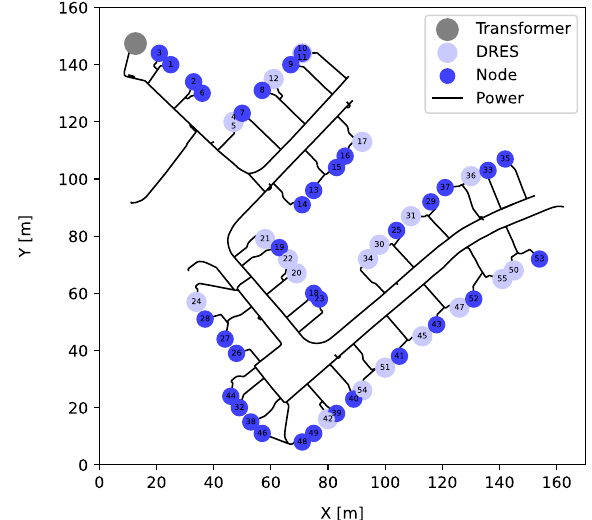
Fig. 3 IEEE 906 low voltage test feeder with 20